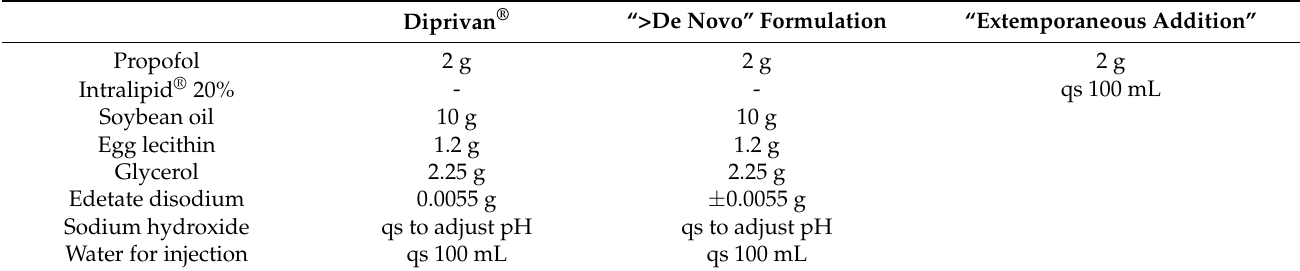
Table 1. Composition of propofol